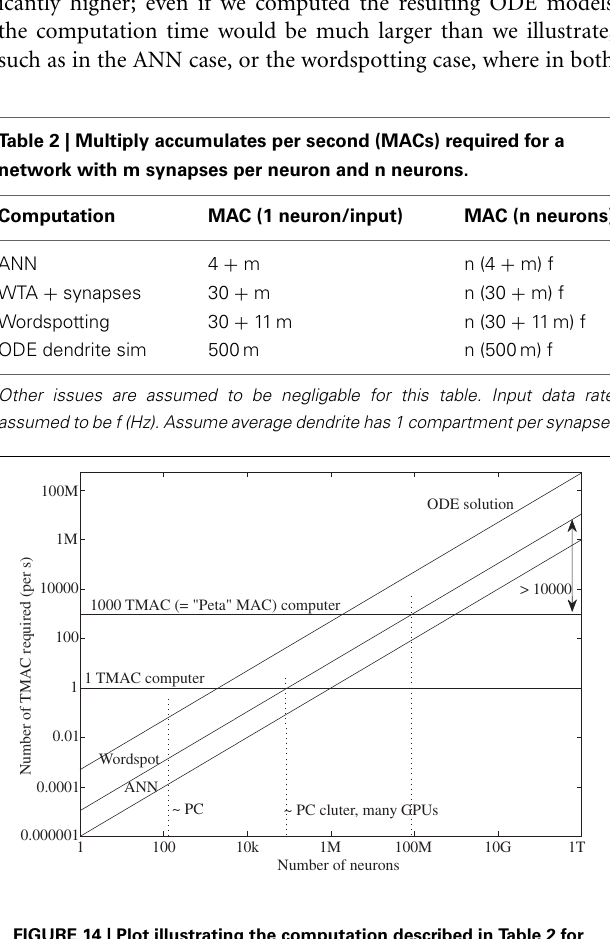
FIGURE 14 | Plot illustrating the computation described in Table 2 for the computation assuming 1000 synapses and assuming real time operating frequency (1kHz). One curve for the ANN and WTA complexity is plotted because they are effectively identical on this plot. To reach a computational level of 10 12 neurons with 1000 synapses or 10 11 neurons with 10,000 synapses, we would be missing a gap of 10,000 in the resulting computational complexity to the wordspotting approach, for the limited level of modeling of biological computation would